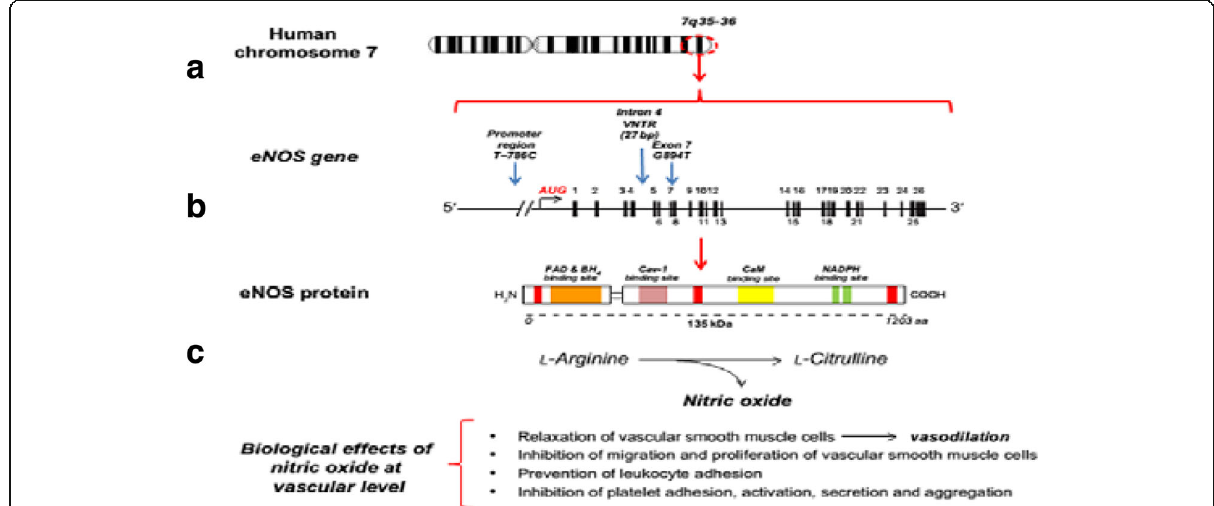
Fig. 1 Scheme of the gene encoding endothelial nitric oxide synthase gene (eNOS) ( a and b ) [18]. Scheme of the gene encoding endothelial nitric oxide synthase (eNOS or NOS3). The human NOS3 gene (located at 7q35-36) contains 26 exons that span 21 kb. Exons are described by number. AUG: the transcription start site. Three specific polymorphisms in the NOS3 gene are marked by arrows. c Scheme of the eNOS